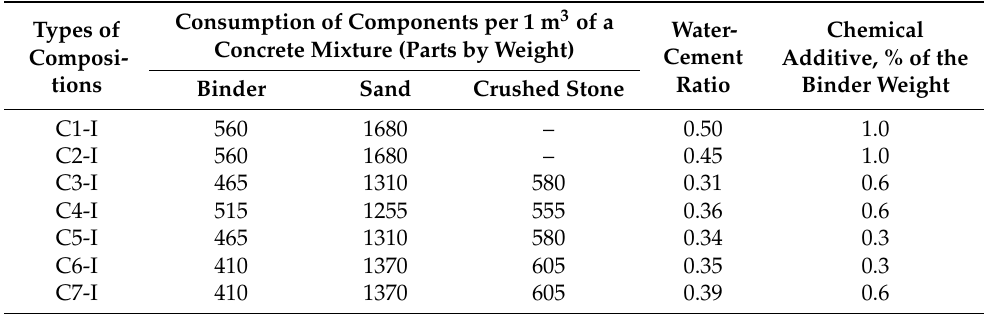
Table 1. Compositions for the analysis of influence of a polycarboxylate additive on concrete with different contents of dust and clay particles in fine